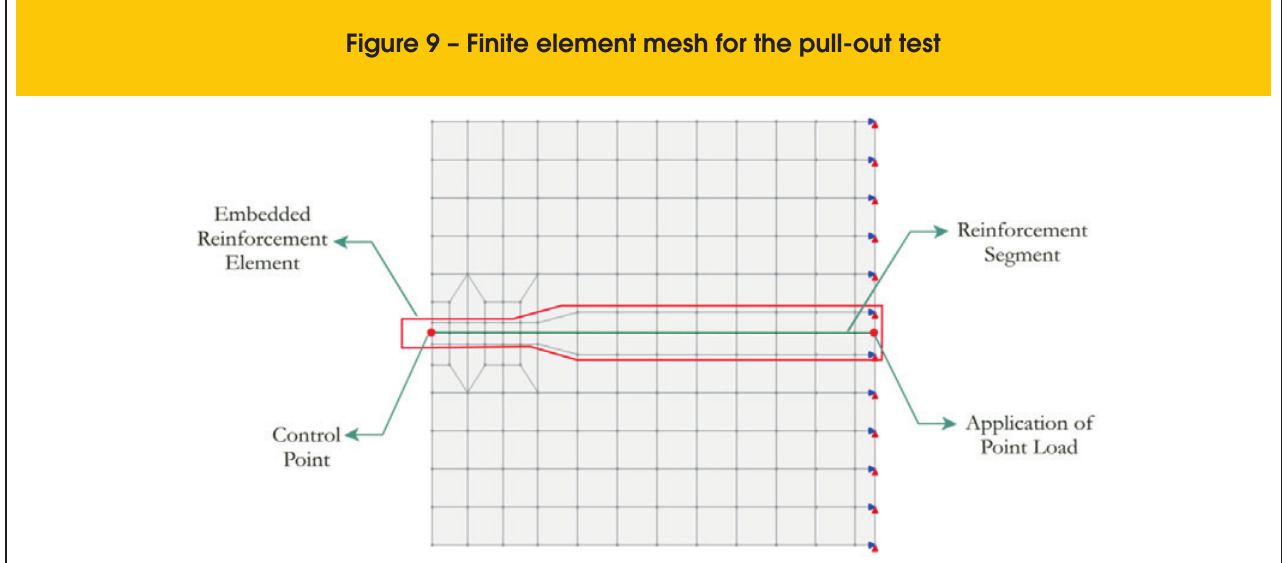
Figure 9 – Finite element mesh for the pull-out test